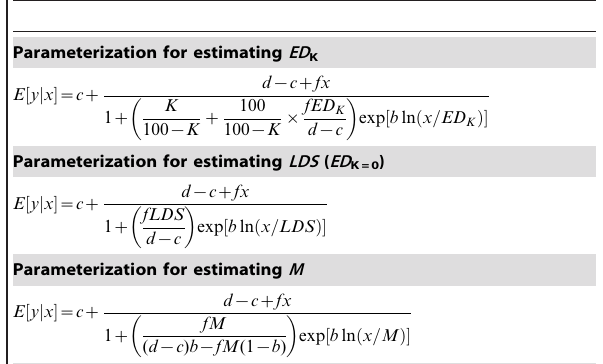
Table 1. Parameterizations of the Brain and Cousens